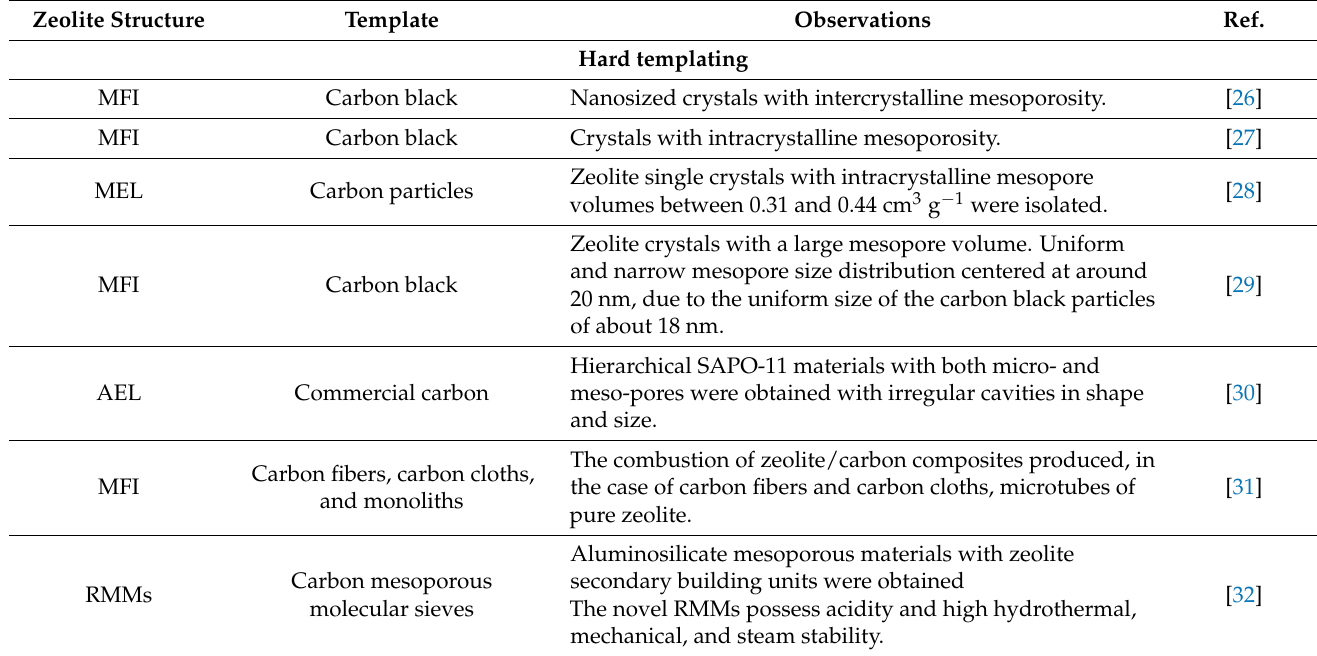
Figure 7. Overview of the various bottom-up synthesis methodologies to obtain hierarchical zeolites. Table 2 resumes some representative examples regarding the application of hard and soft templating strategies for the synthesis of hierarchical zeolites. A few examples, related with the targeted reactions of this review, are briefly mentioned in the following section, and selected case-studies are discussed in detail ahead. Table 1. Examples of recent studies on bottom-up processes used to synthetize hierarchical zeo- lite